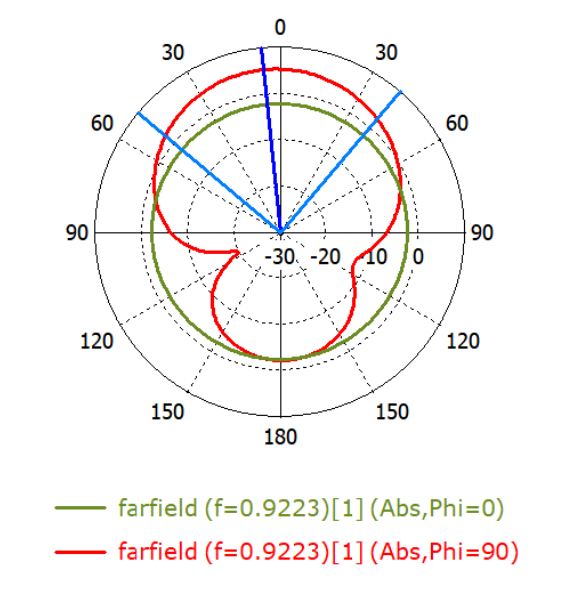
Fig. 3. Radiation pattern in both E and H planes.